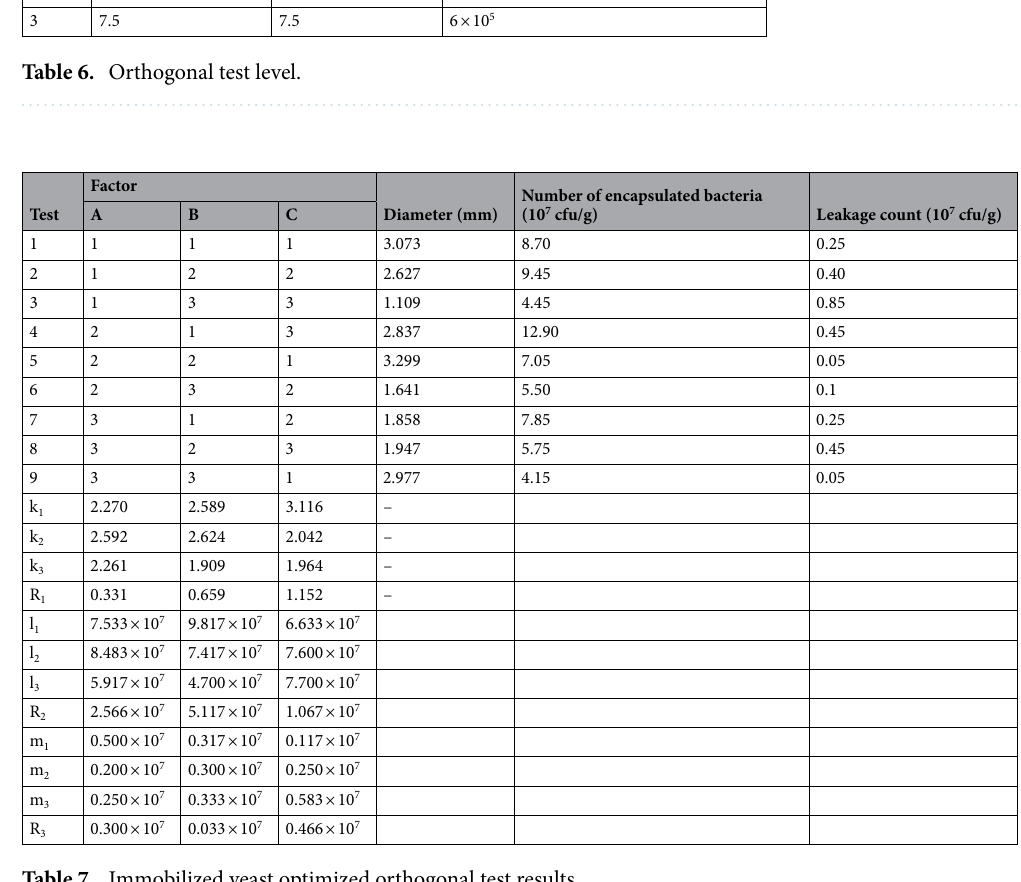
Table 7. Immobilized yeast optimized orthogonal test